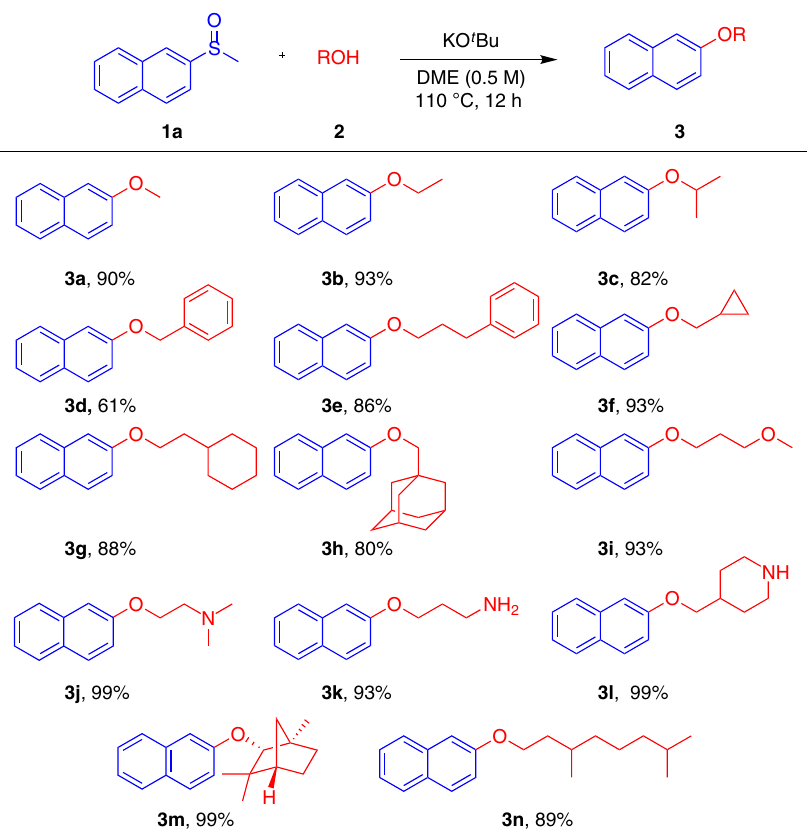
Fig. 2 Substrate scope alcohols with 1a. All reactions were conducted with 1a (0.2 mmol), 2 (0.4 mmol), KO t Bu (0.4 mmol) in DME (0.4 mL) under argon atmosphere at 110 °C for 12